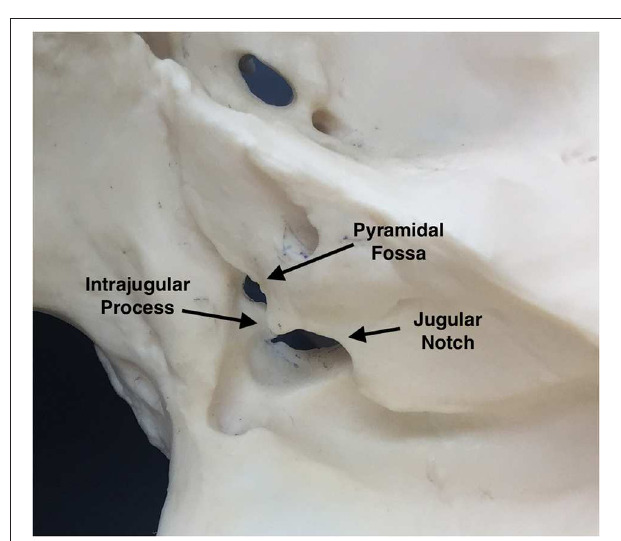
FIGURE 3 | Parts of the roof of the jugular foramen (right intracranial view) [Modified from Ramina and Tatagiba ( 3)].